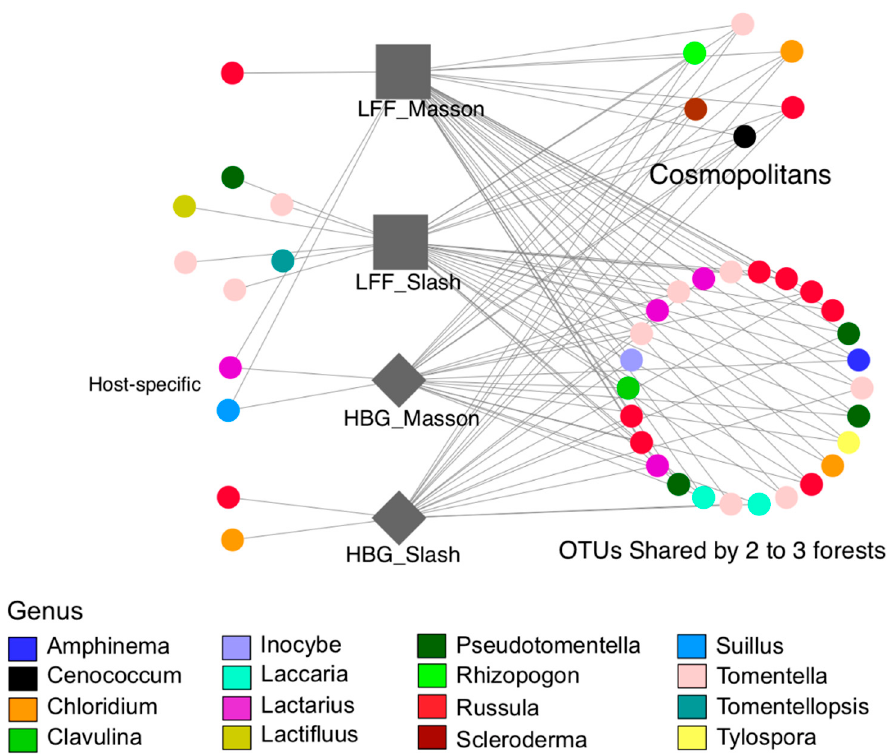
Figure 2. A network map showing the interactions of the OTUs among all the samples from different hosts at each site. Each point represents one independent fungal OTU (43 OTUs in total) . OTUs in the left column were unique to one forest type, while those in the right belonged to multiple forest types.